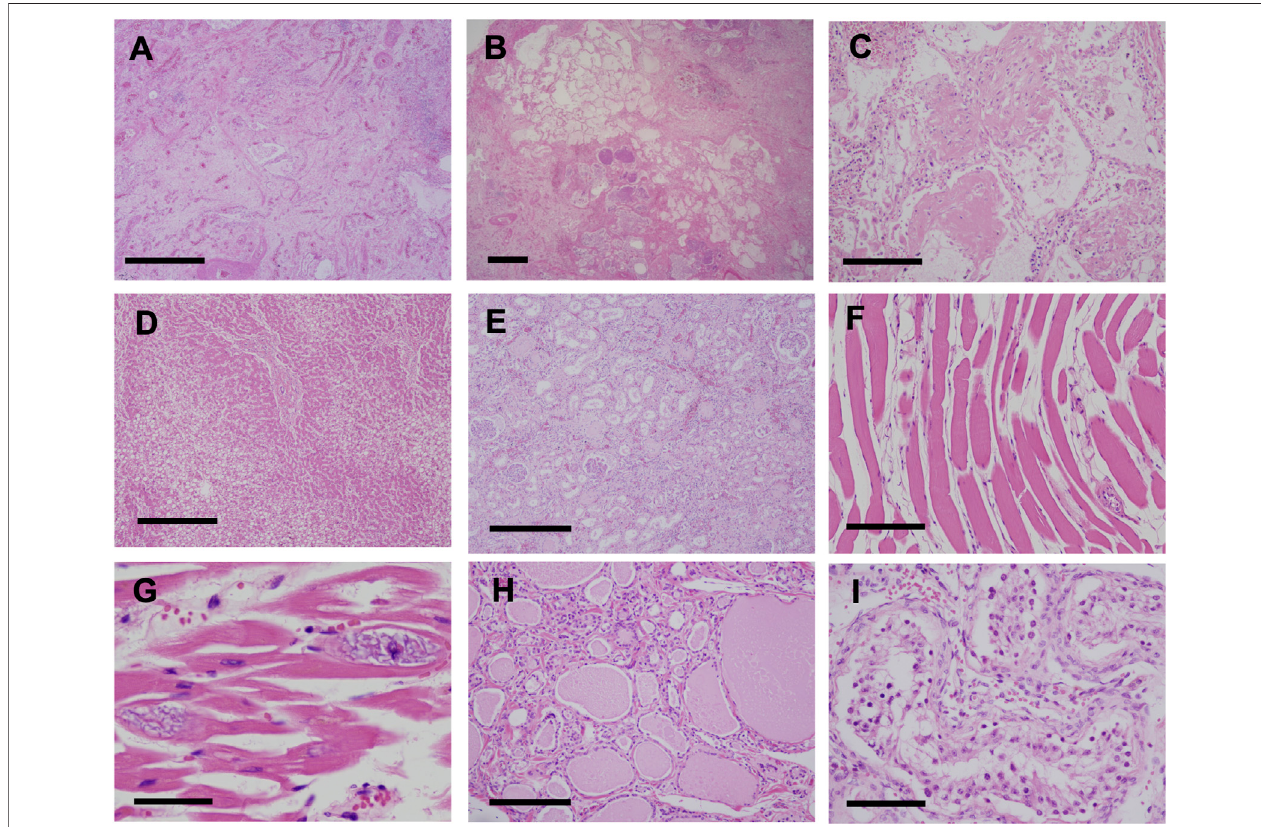
FIGURE 4 | Pathological fi ndings (H&E stain) (A,B) Fibrotic changes with unclassi fi able pattern predominantly in the right upper lobe of the lung (A) Fibrotic- nonspeci fi c interstitial pneumonia (f-NSIP) pattern (scale bar, 1.0 mm) (B) Usual interstitial pneumonia (UIP) pattern and bacterial pneumonia with gram-positive cocci (scale bar, 1.0 mm) (C) Organizing pneumonia (scale bar, 200 μ m) (D) Liver tissue showed fi brosis and fatty degeneration (scale bar, 500 μ m) (E) Interstitial fi brosis, glomerular sclerosis, and tubular atrophy in the kidneys (scale bar, 500 μ m). Skeletal muscles (scale bar, 200 μ m) (F) and the myocardium (scale bar, 100 μ m) (G) showed atrophy, fatty degeneration, and basophilic degeneration (H) Thyroid tissue showed atrophy and interstitial fi brosis (scale bar, 200 μ m) (I) Testis tissue showed atrophy of the seminiferous tubules, indicating male infertility (scale bar, 100 μ